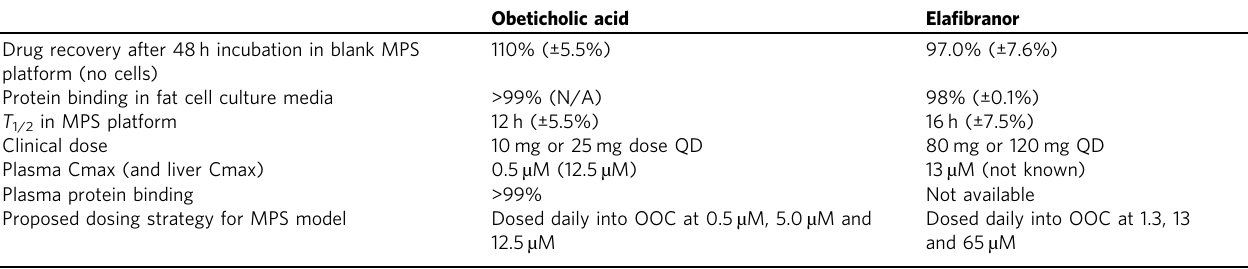
Table 1 Determining translationally relevant drug concentrations for use in liver MPS NASH model